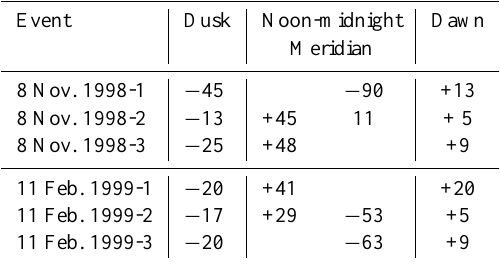
Table 2. Local potential extrema (kV). Event